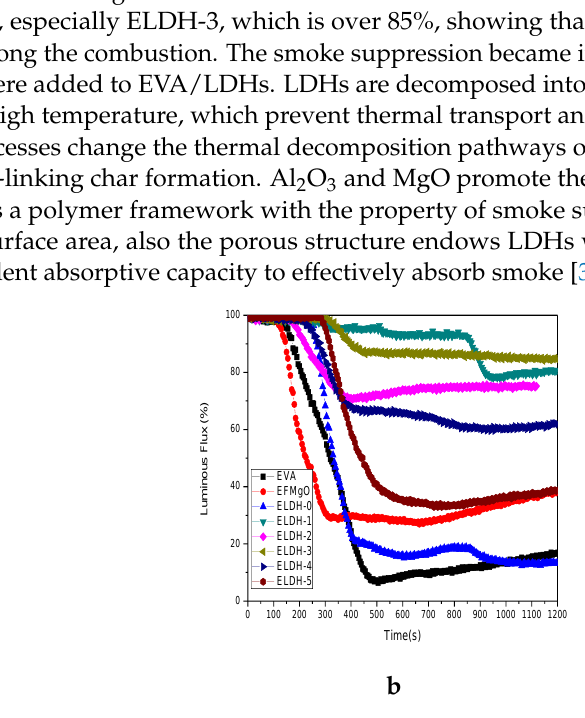
Figure 8. Luminous Flux curves of all EVA/LDHs Composites: ( a ) without and ( b ) with the application of the pilot flame.